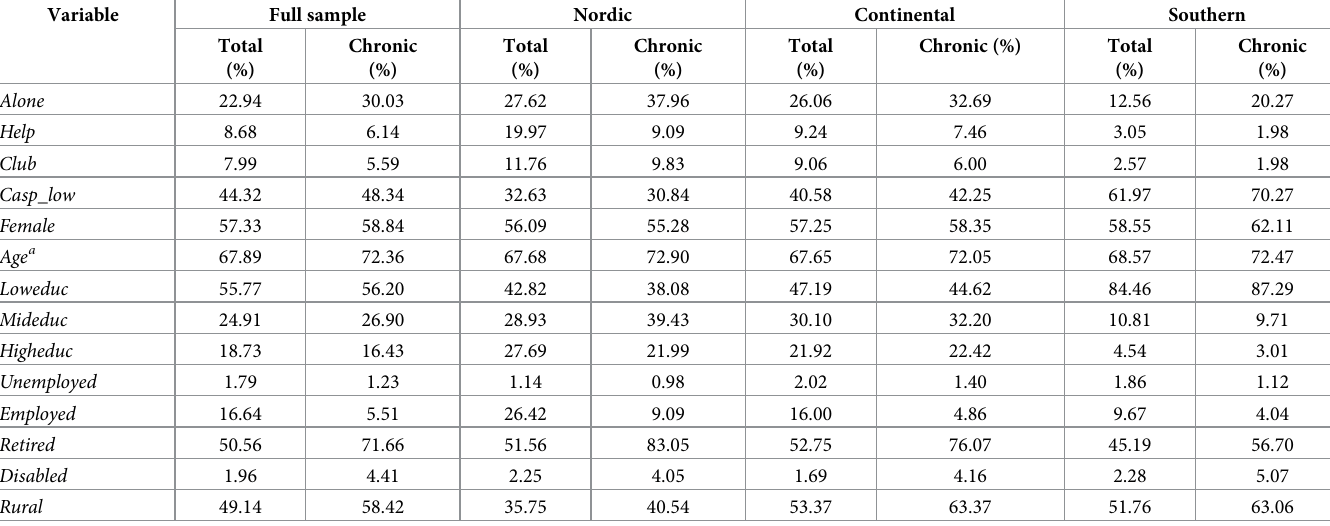
Table 3. Descriptive statistics of the analytical sample by geographic macro-area (all countries (9); sample size (n) = 37,864).